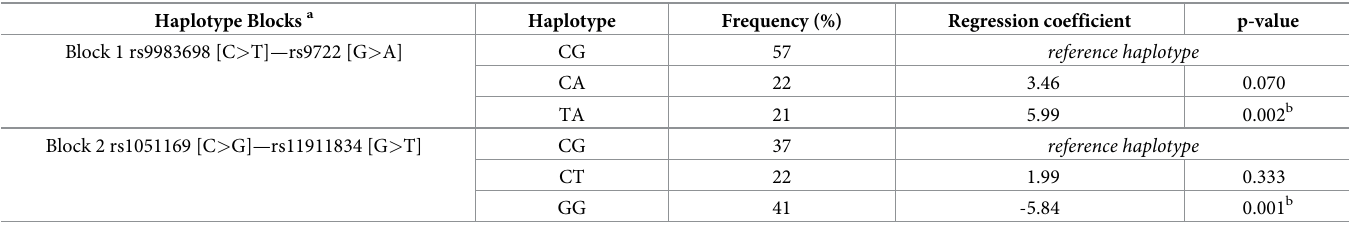
Table 7. Haplotype frequencies and CPI association analyses.